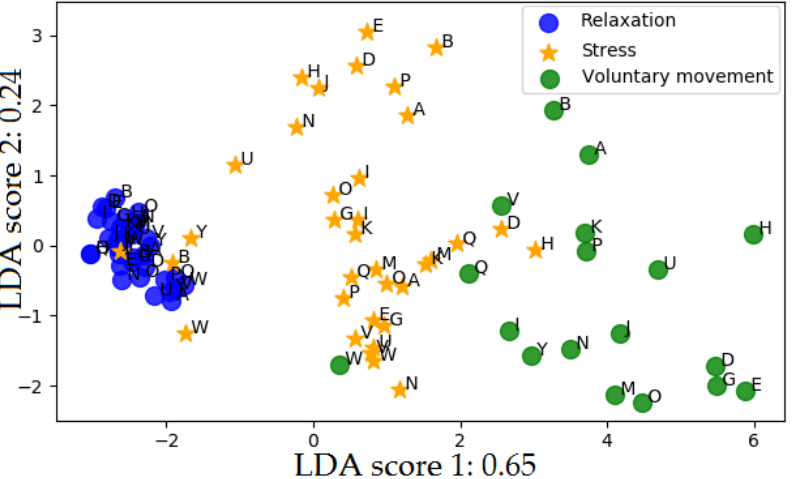
Figure 14. The graphical response of the linear discriminant analysis (LDA) algorithm on the EMG feature set.